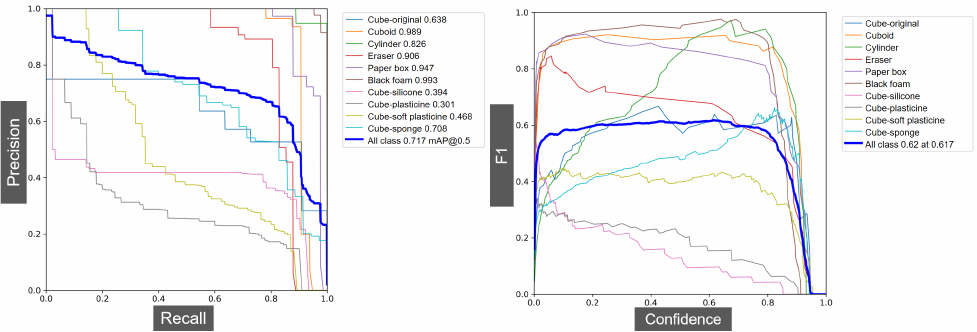
Figure 6. The validation results of YOLOv5 network after 500 epochs with 600 pictures. The mAP of all classes is 0.717. The accuracy and F1 score of the cubes with different fillers are relatively low (the lowest is only 0.301 and average is 0.502) due to their similar appearances. This indicates the necessity of adding haptic-related features for